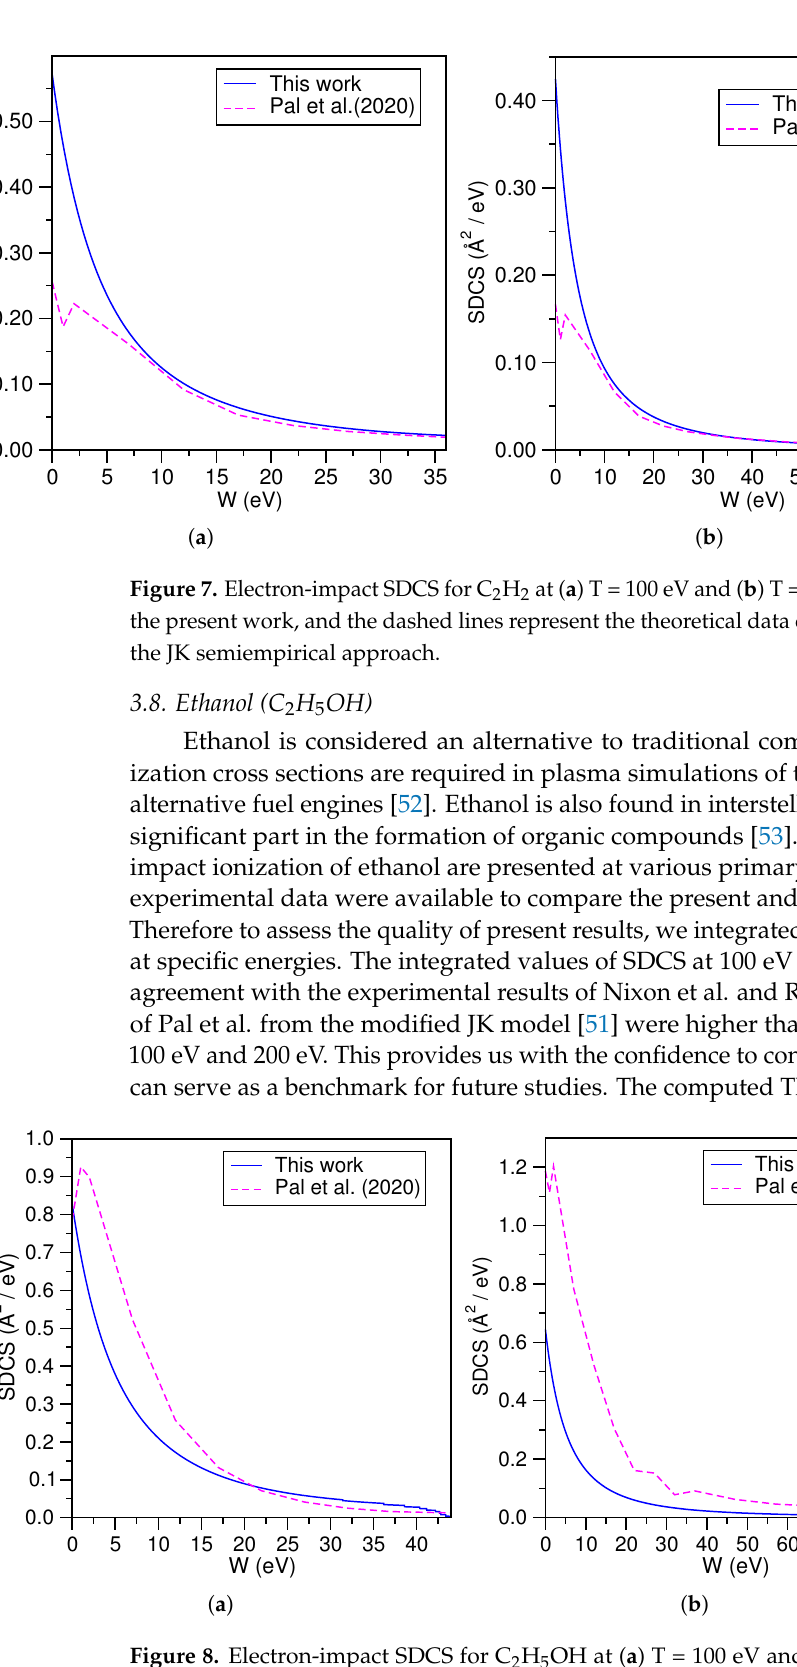
Figure 8. Electron-impact SDCS for C 2 H 5 OH at ( a ) T = 100 eV and ( b ) T = 200 eV. The solid lines represent the present work, and the dashed lines represent the theoretical data of Pal et al. [51], computed using a JK semiempirical